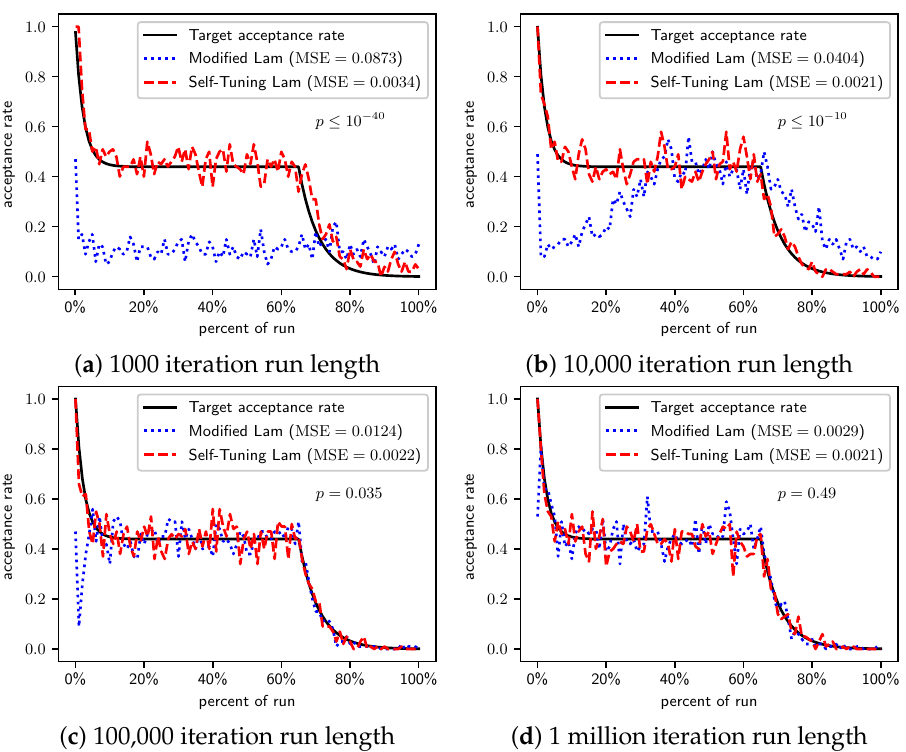
Figure 19. Minimize g 100 ( x ) : Self-Tuning Lam, Modified Lam, and target acceptance rates for